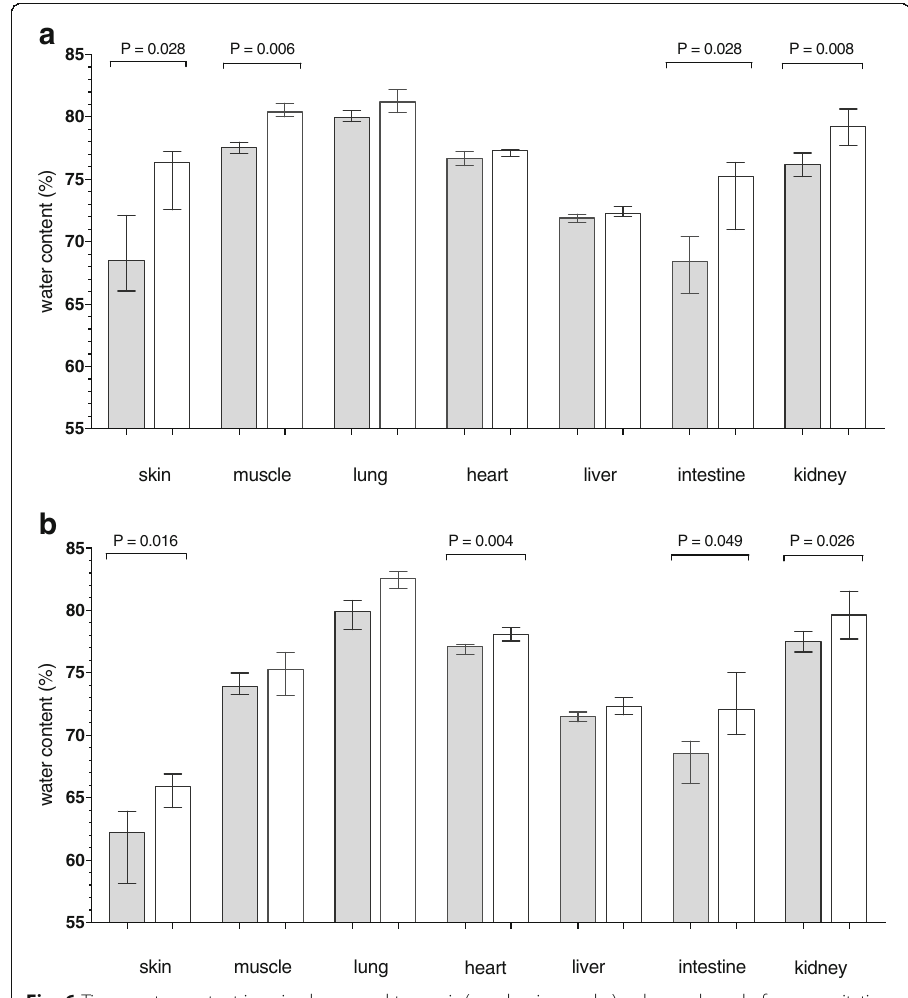
Fig. 6 Tissue water content in animals exposed to sepsis (gray bar in panel a ) or hemorrhage before resuscitation (gray bar in panel b , n = 4 in both conditions) and after resuscitation with Ringers acetate at a dose of 100 ml/kg (white bars, n = 8 in both conditions). Differences in water content were analyzed using Mann – Whitney nonparametric